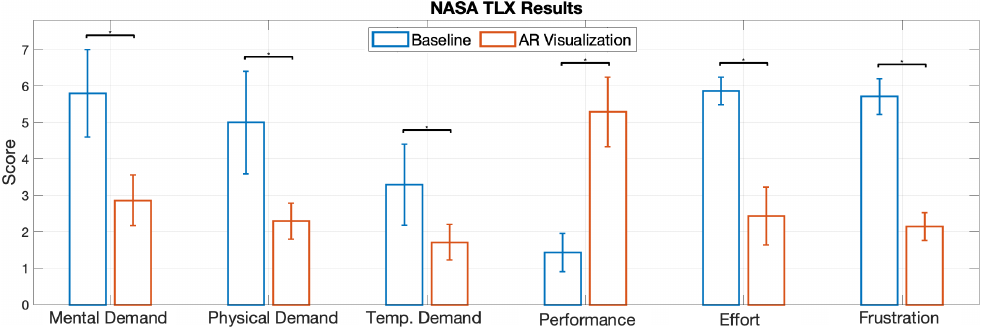
Figure 9. Subjective task load rating for the